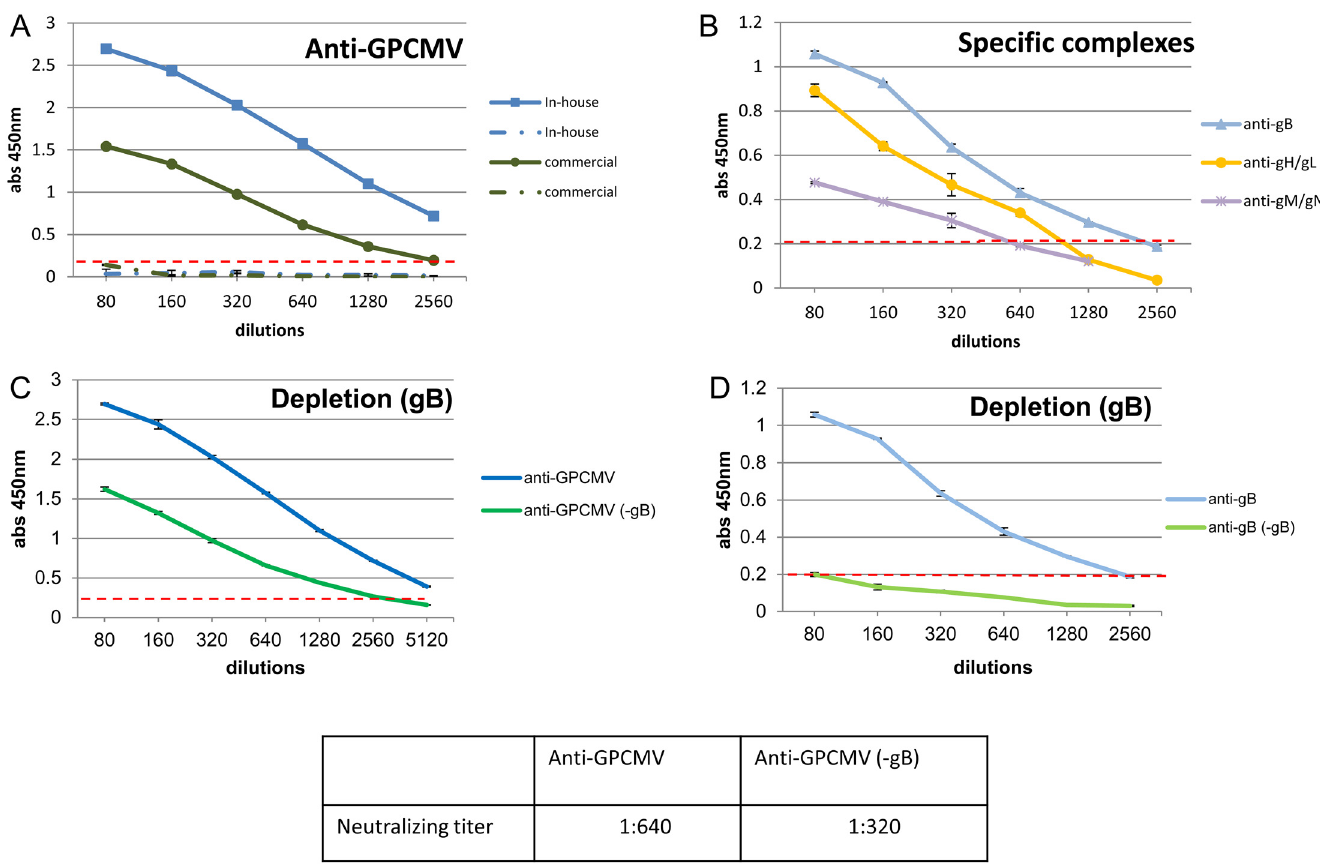
Fig 10. Antibody immune response of convalescent guinea pigs to GPCMV and GPCMV glycoprotein complexes determined by ELISAs. Pooled sera from GPCMV infected convalescent animals was used to evaluate immune response to GPCMV (A) or to specific glycoprotein complexes (B). (A) Anti- GPCMV ELISA. The immune response to GPCMV antigens was analyzed by an in-house ELISA (blue line square) compared to commercially available GPCMV ELISA kit from Bioexpress (green line circle). GPCMV sera negative for both assays are shown in blue and green dotted lines. (B) Immune response of convalescent pooled guinea pig serum to individual glycoprotein complexes. Anti-gB, light blue line (triangle); Anti-gH/gL, orange line (closed circle); Anti- gM/gN, purple line (star). Convalescent sera depleted of anti-gB antibody (-gB) (as described in materials and methods) was retested by ELISA to (C) anti- GPCMV ELISA (solid green line) to demonstrate retention of antibody response to other viral antigens, and (D) anti-gB specific ELISA (solid light green line) to demonstrate gB depletion compared to the original undepleted sera. All sera were diluted from 1:80 to 1:2560 in doubling dilutions. Control sera from animals negative for GPCMV were used for base line in all assays. ELISAs performed as described in materials and methods. Base level for background indicated by horizontal dotted red